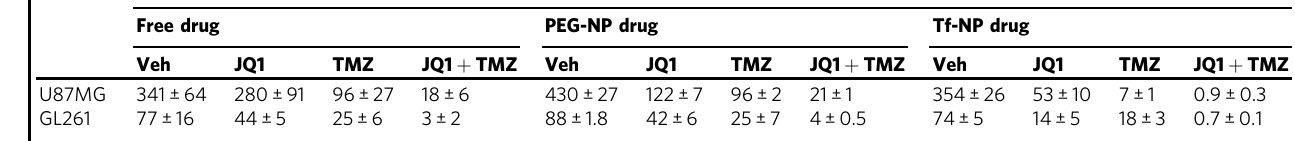
Cell line Average fold increase in tumor bioluminescence at day 7 of treatment